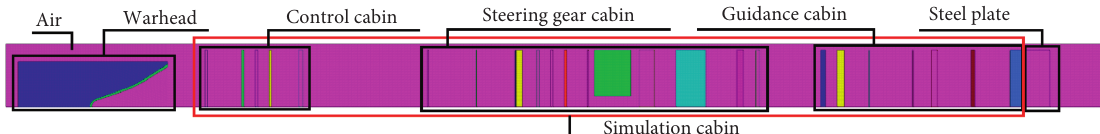
Figure 3: Finite element model.